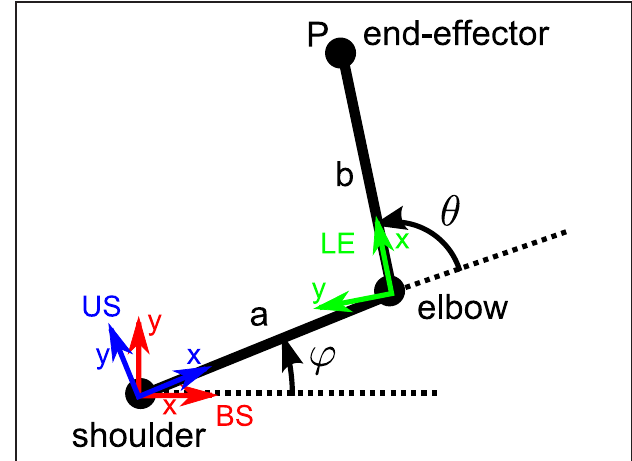
FIGURE 3 | Two-link arm top view. The shoulder insertion point, elbow and end-effector location are represented. The different reference frames are also represented: body-fixed shoulder-centered (BS, in red), upper arm -fixed shoulder-centered (US, in blue), and the lower arm -fixed elbow centered (LE, in green). The rotation angles of the shoulder and elbow are respectively denoted ϕ and θ